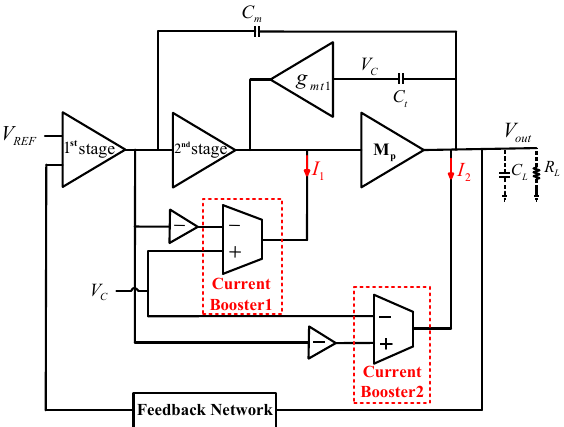
Figure 1. Conceptual structure of the proposed OCL − LDO regulator.